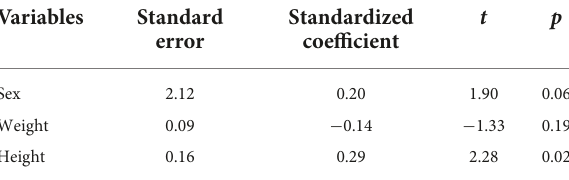
TABLE 4 Multiple linear regression analysis of LSVC.